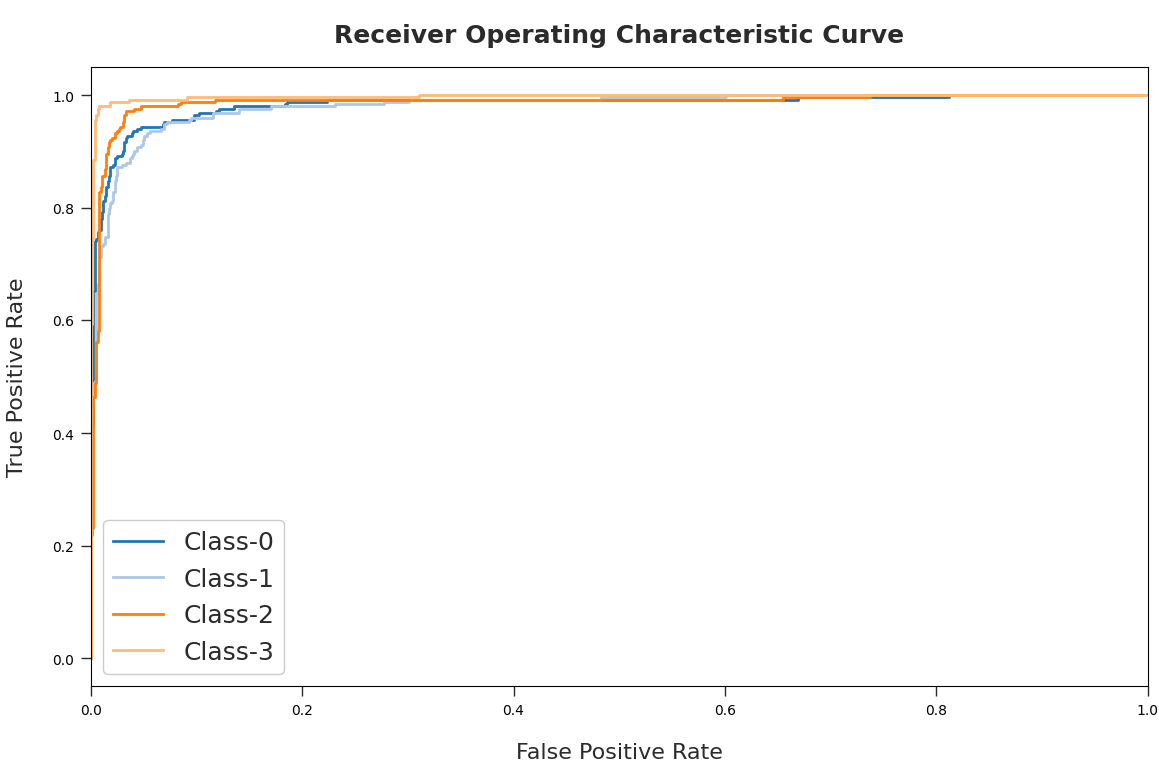
Figure 10. ROC curve analysis of MDTL-ICDDC technique.